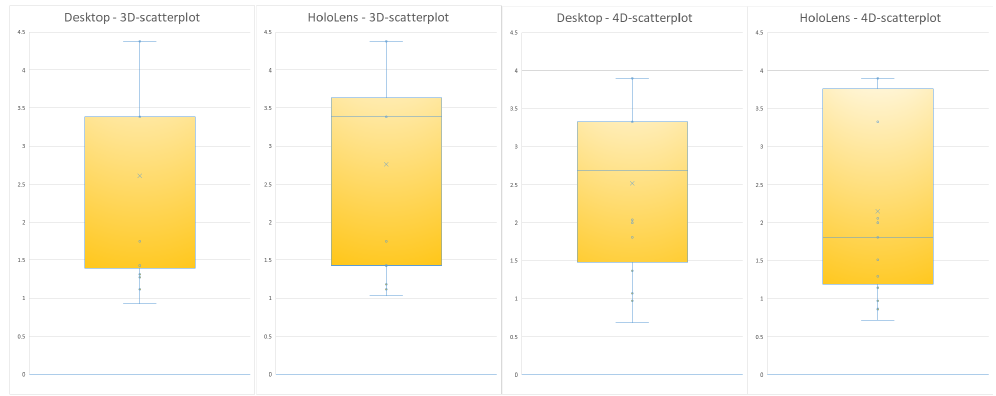
Figure 10. An overview of the cars selected by the evaluators in the different scenarios and their price-performance ratios from the scatterplot